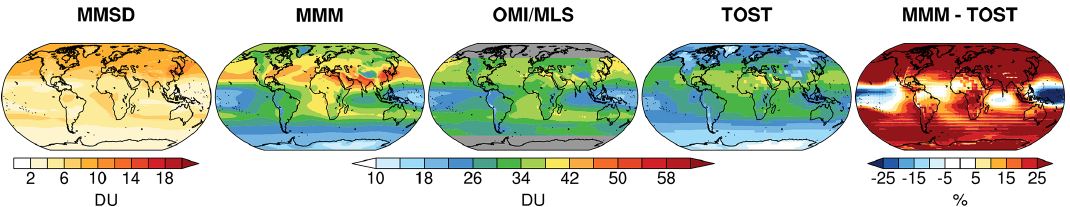
Figure 6. Comparison of the annual tropospheric column of ozone (TCO) abundance with satellite (OMI/MLS) and ozonesonde-derived (TOST) climatologies for the period 2005 to 2014. The leftmost panel shows the inter-model standard deviation of annual mean TCO in the CMIP6 ensemble in Dobson units (DU). The second panel from the left shows the multi-model annual mean TCO in DU. The middle panel shows the annual mean TCO in the OMI/MLS product (Ziemke et al., 2006). The second panel from the right shows the annual mean TCO in the TOST product (Liu et al., 2013b, a). The rightmost panel shows the relative bias in the multi-model mean relative to the TOST product in percent